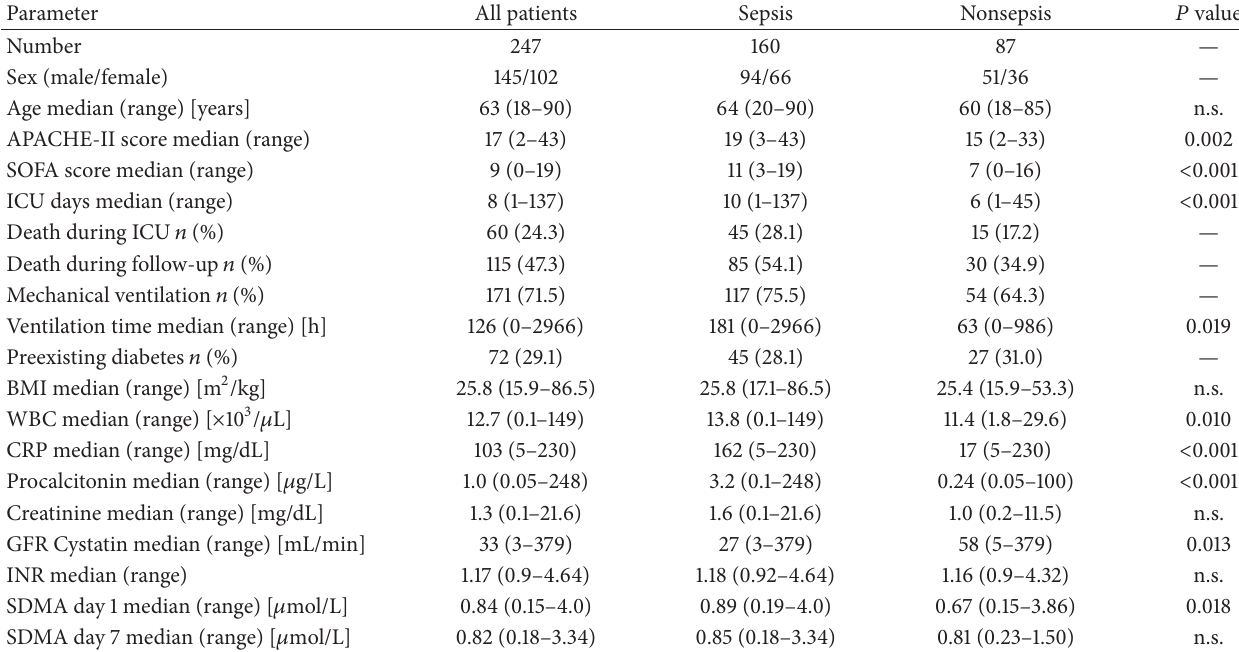
Table 1: Baseline patient characteristics and SDMA serum